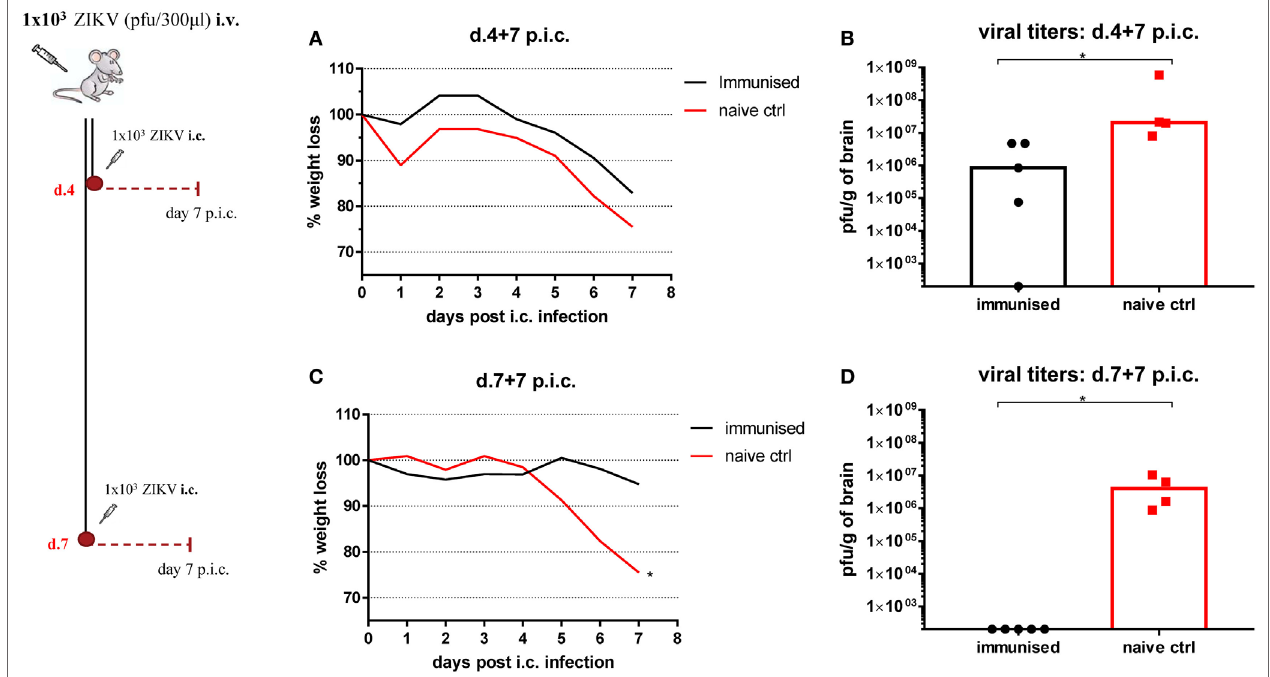
FigUre 6 | How quickly is protection induced? Wild-type C57BL/6 mice were inoculated with 1 × 10 3 pfu Zika virus (ZIKV) i.v. and on days 4 (a,B) or 7 (c,D) post i.v. inoculation mice were challenged with 1 × 10 3 pfu ZIKV i.c. Mice were weighed and monitored daily (a,c) , and on day 7 post i.c. challenge, brains were removed and viral titers were measured by a plaque assay (B,D) . Groups of naïve mice were used as negative controls. The detection limit for virus in the brain was 250 pfu/g organ. Each dot represents an individual animal, and bars represent the medians of the groups. The weight curves depict the group medians. n = 4–5 mice/group, * p < 0.05. The complete resistance observed 7 days post immunization was confirmed in a second